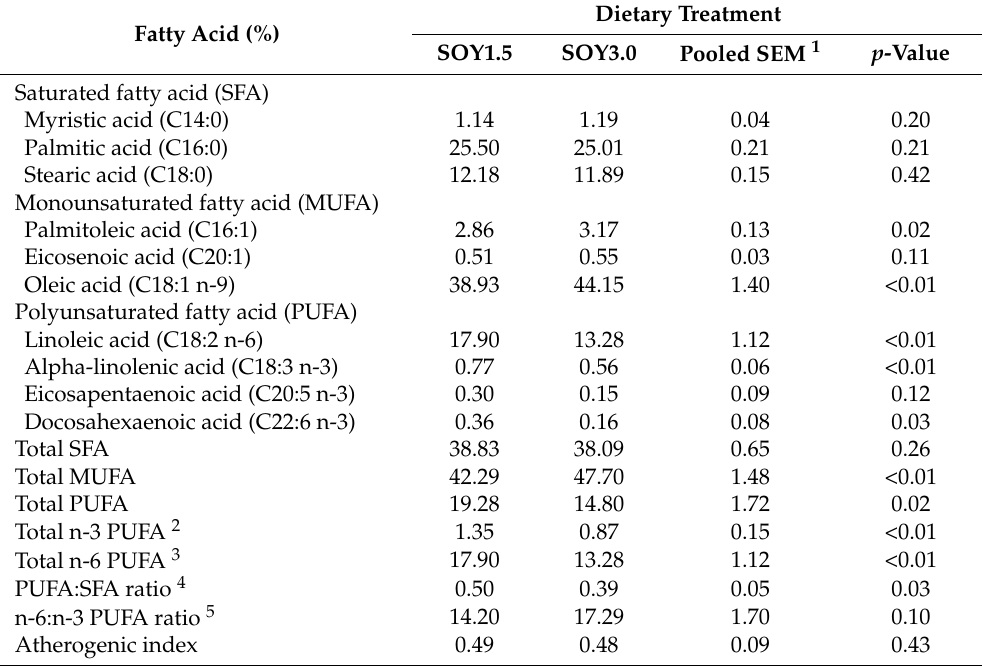
Table 1. Effects of dietary treatments on fatty acid profile of Longissimus lumborum intramuscular fat of pigs. Dietary Treatment Fatty Acid (%) SOY1.5 SOY3.0